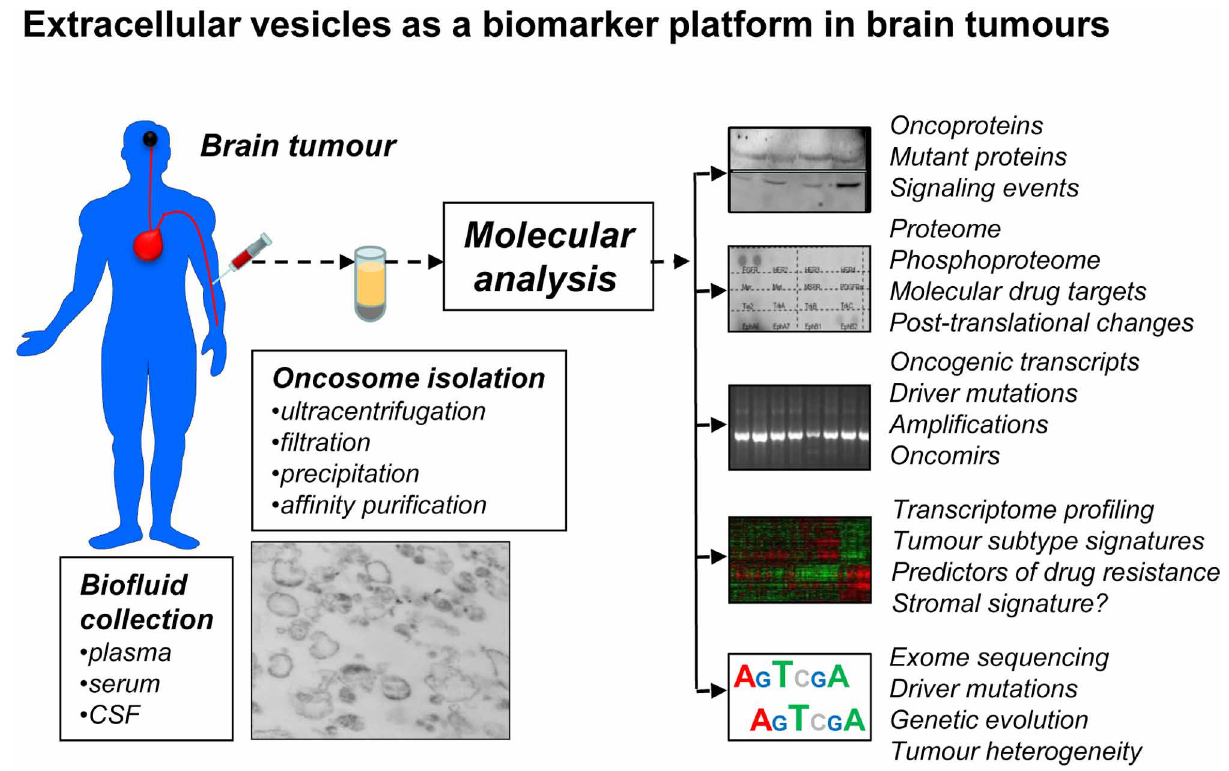
for the purpose of monitoring putative drug targets and their responses to targeted therapies. EVs may provide information as to new, or pre-existing mutations that may occur in brain tumor cells, as well as scope and phylogeny of driver events, for example by sequencing nucleic acids (DNA, RNA) in the cargo. Profiling of proteins and nucleic acids may reveal signatures of brain tumor subgroups and individual variations in gene expression. The challenge is to develop technologies that would ensure sensitivity, specificity, reproducibility and processing of this information for clinical